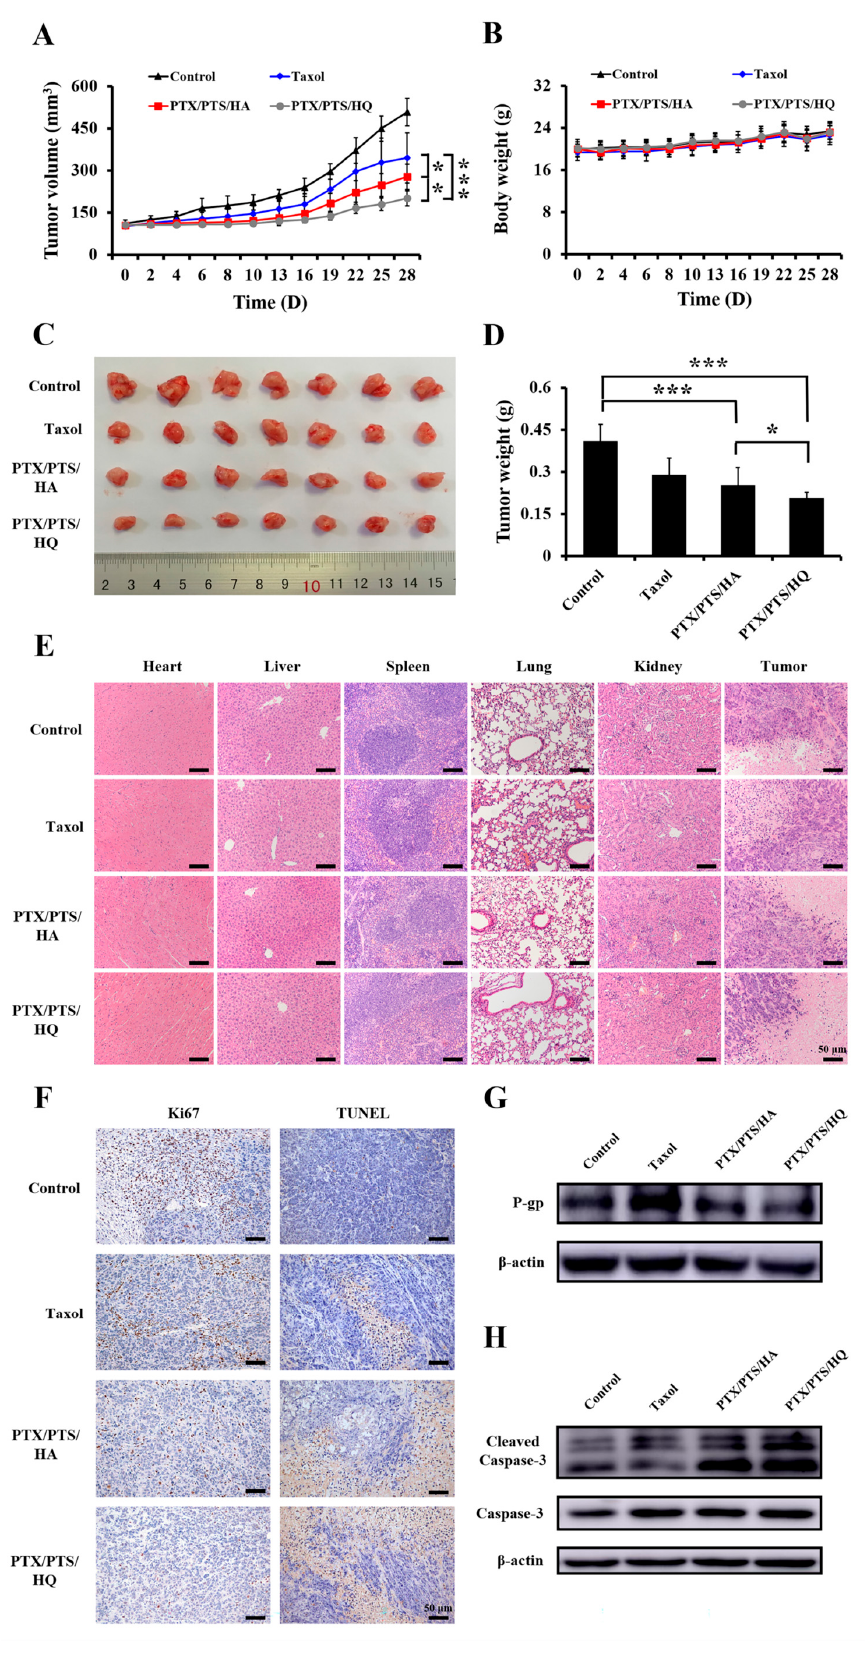
Figure 7. In vivo antitumor therapeutic efficacy of PTX/PTS/HQ PNPs in MCF-7/ADR tumor- bearing nude mice. ( A ) Tumor volume evolution and ( B ) body weight changes within the